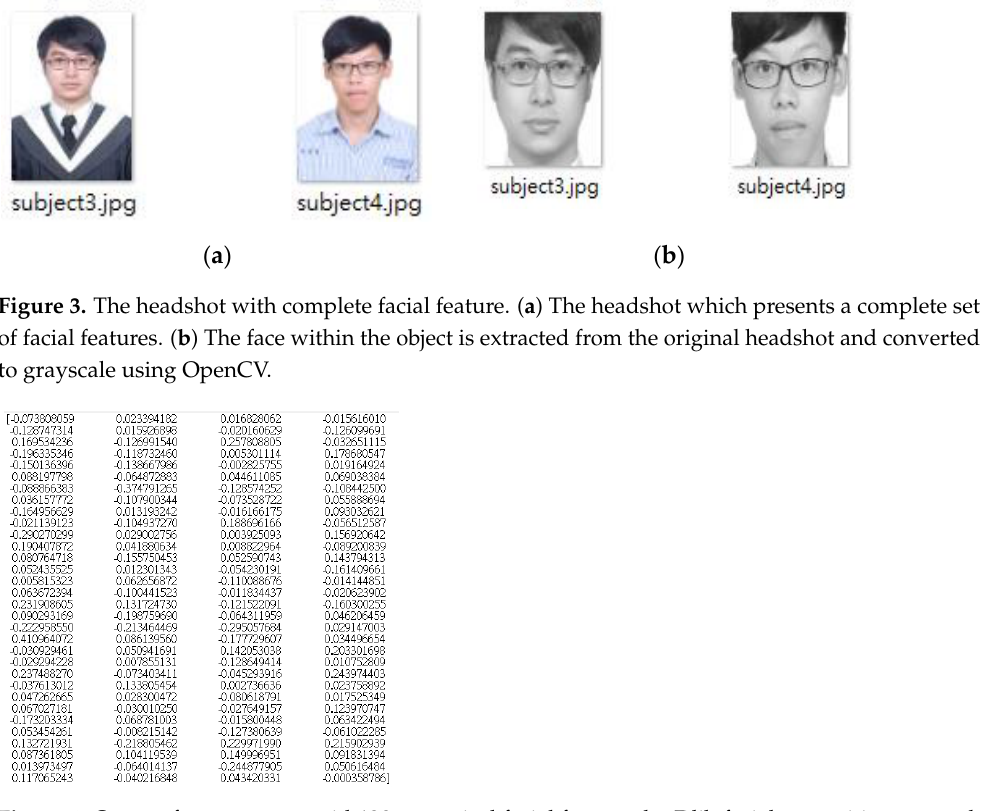
Figure 4. Output feature vector with128 numerical facial features by Dlib facial recognition network which was sipped from the python results.